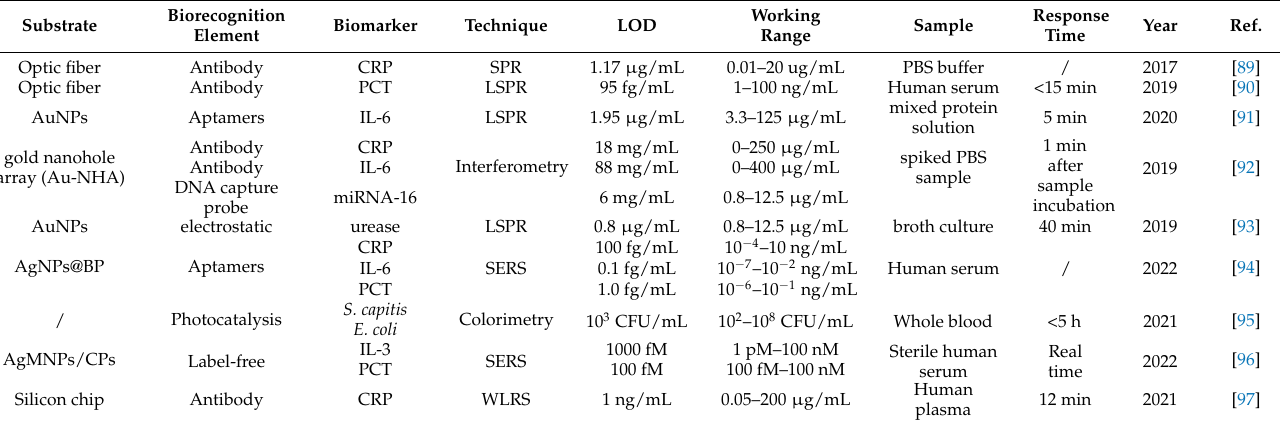
Table 3. List of optical biosensors and their main